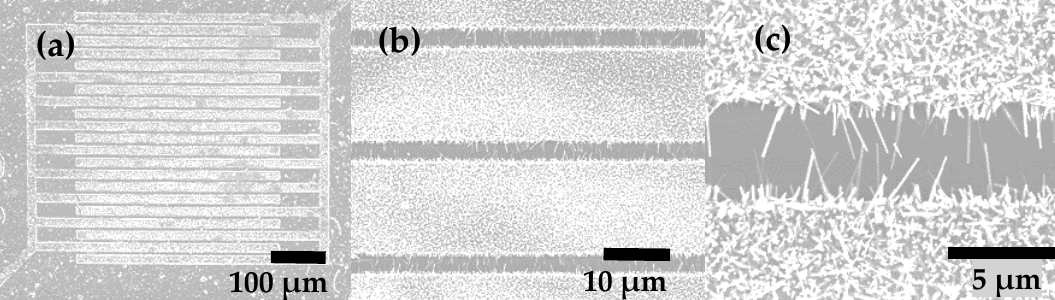
Figure 4. ( a – c ) SEM images of ZnO NWs on Si/SiO 2 substrates with prepatterned Au electrodes at different magnifications. (The spacing between the electrodes in all images is 5 µm).